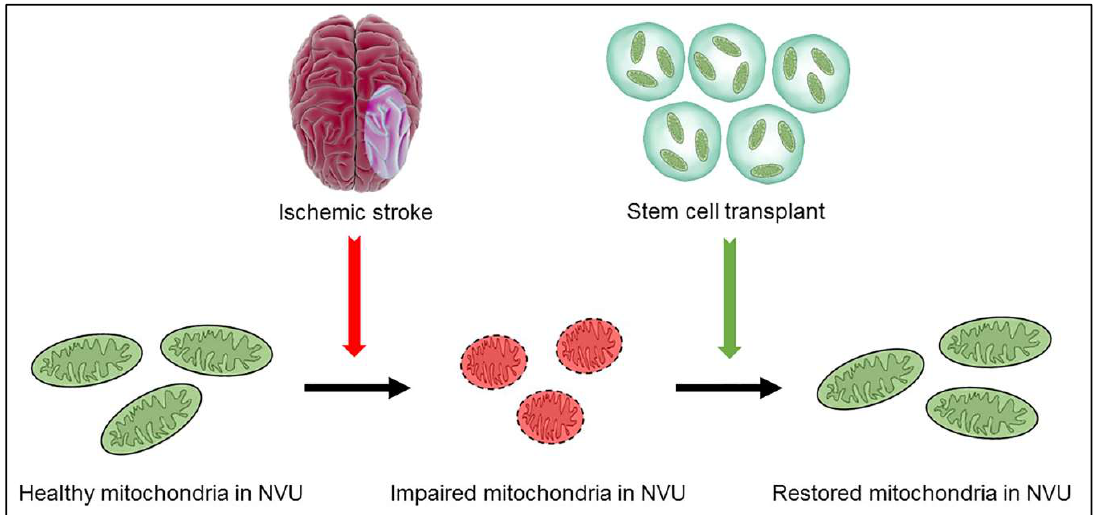
Figure 1. Schematic diagram illustrating mitochondrial replacement strategy. After ischemic stroke, healthy mitochondria in the neurovascular unit (NVU) undergo structure and function impairment. Stem cells transplantation enables the replacement of dysfunctional mitochondria in the NVU with healthy mitochondria from the transplanted stem cells.